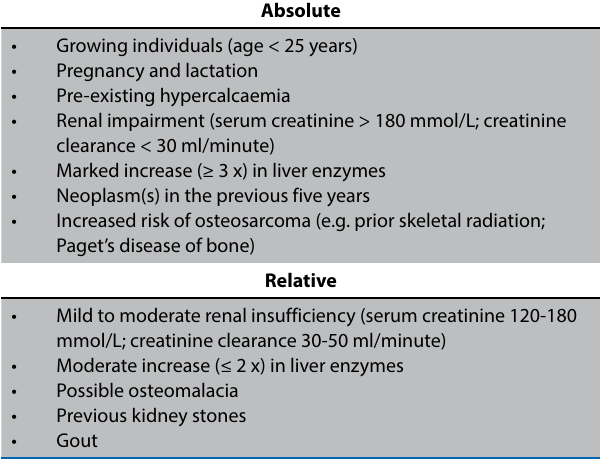
Table XIII: Contraindications to the use of teriparatide/PTH